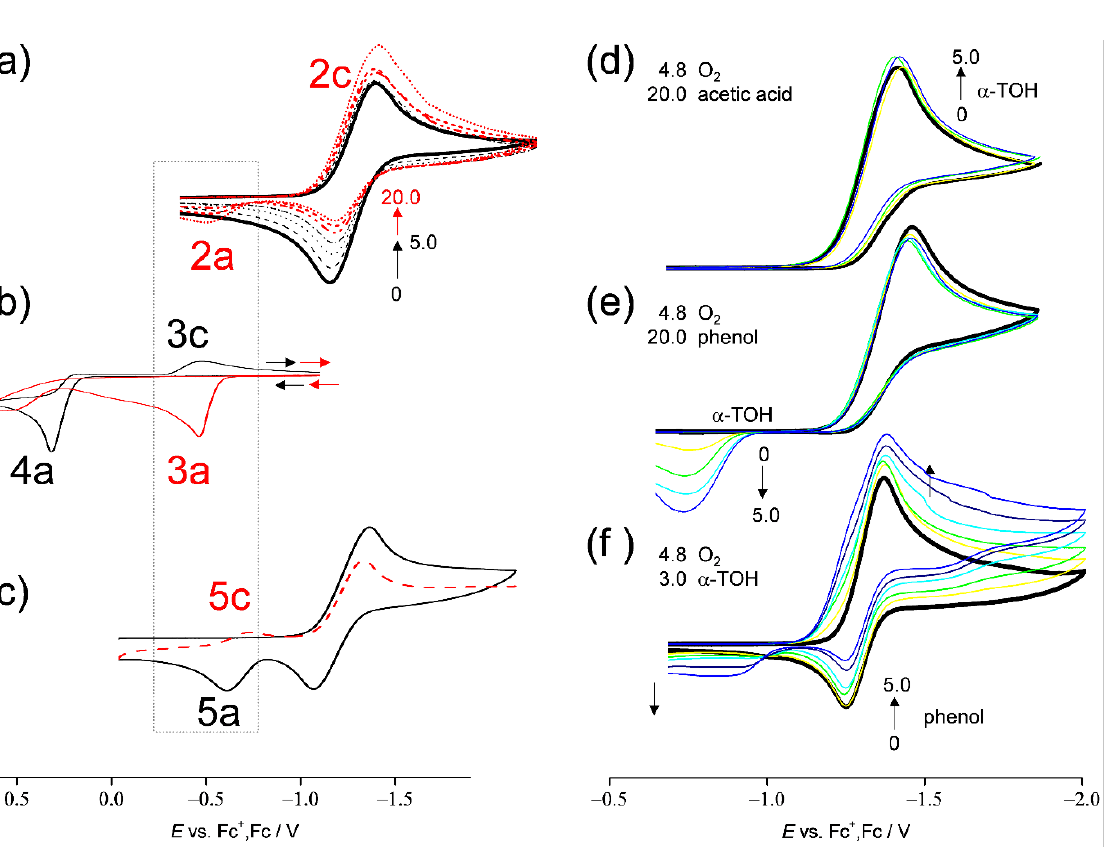
Figure 4. CVs of ( a ) O 2 in the presence of various concentrations (0, 1.0, 2.0, 3.0, 5.0, 10.0, and 20.0) of α -TOH, ( b ) α -TOH (5.0) in the absence (black line) and the presence of sodium methoxide (20.0, red line), ( c ) O 2 in the presence of α -TOH (7.0) for the first cycle (black line) and the second cathodic scan (red line), O 2 in the presence of both α -TOH (0, 1.0, 3.0, and 5.0) and ( d ) acetic acid (20.0), ( e ) phenol (20.0), and ( f ) O 2 in the presence of both α -TOH (3.0) and phenol (0, 1.0, 3.0, and 5.0), in DMF containing 0.1 mol dm − 3 TPAP, recorded on a GC electrode ( Φ = 1.0 mm) at scan rates of ( a , b , d – f ) 0.1 and ( c ) 1.0 V s − 1 . The concentration ( × 10 − 3 mol dm − 3 ) changes are shown by the